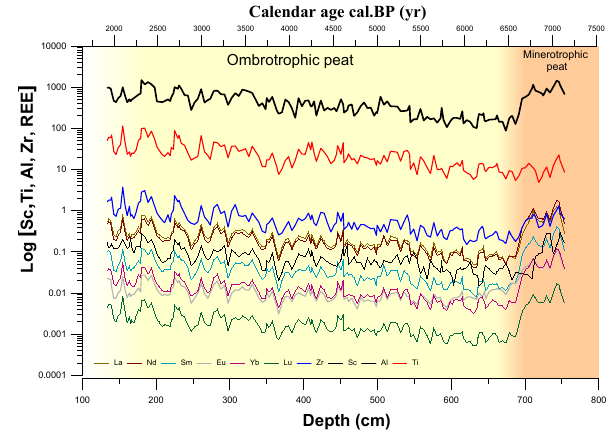
Fig. 4. Concentrations of Ti, Al, Sc, Zr and REE for the MIS-08- 01b core. The yellow area corresponds to ombrotrophic peatland, the brown area to minerotrophic peat as defined by using Ca/Mg ratios, Sr concentration and testate amoebae assemblages.